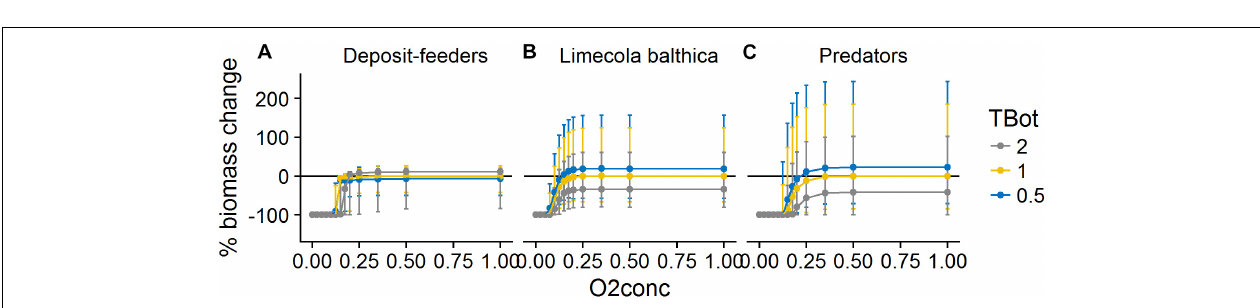
FIGURE 7 | Change in biomass of deposit-feeders (A) , L. balthica (B) , and predators (C) as a function of relative changes in Sed and O2Conc, where 1 denotes baseline forcing. Biomass change is relative to baseline equilibrium value. Error bars show the variability in biomass change due to varying TBot. Horizontal line indicates no change. Forcing abbreviations are explained in Table 1 .